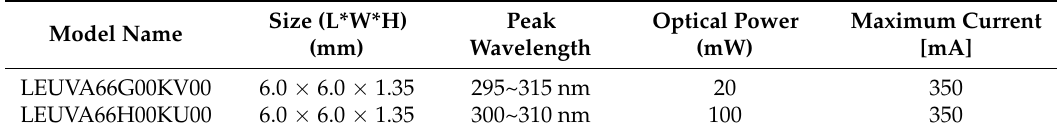
Table 3. Specifications of UVB LEDs (LG InnoTek).